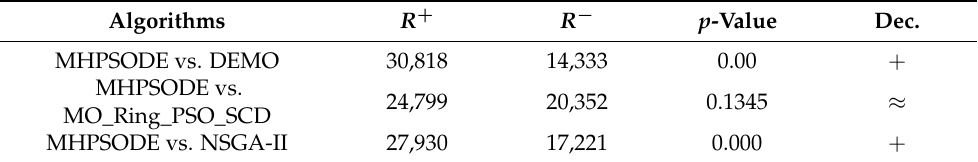
Table 4. The statistical results of the Wilcoxon’s test between HPSODE and other considered algo- rithms on CEC2009 benchmark.